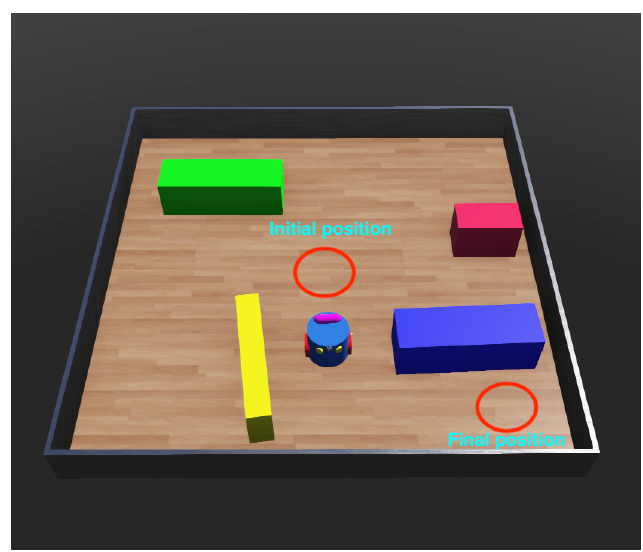
Figure 5. An example of the Webots environment with the initial position and final position. The robot has the goals of going from the initial position to the final position while avoiding obstacles. The robot will be returned to its initial position after any collision.